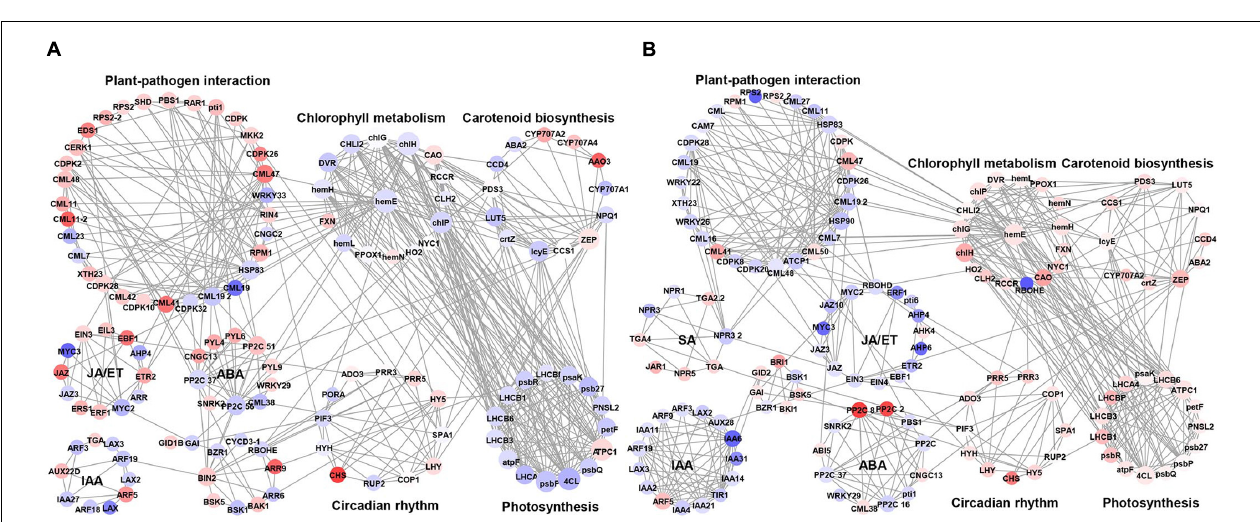
Frontiers in Plant Science |